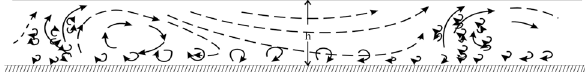
Fig. 1. Distribution of turbulent vortices according to V. A. A. Vanoni (1959) Bottom vortices originate often as a result of flow separation from the bottom unevenness; therefore, they are displaced along the flow somewhat